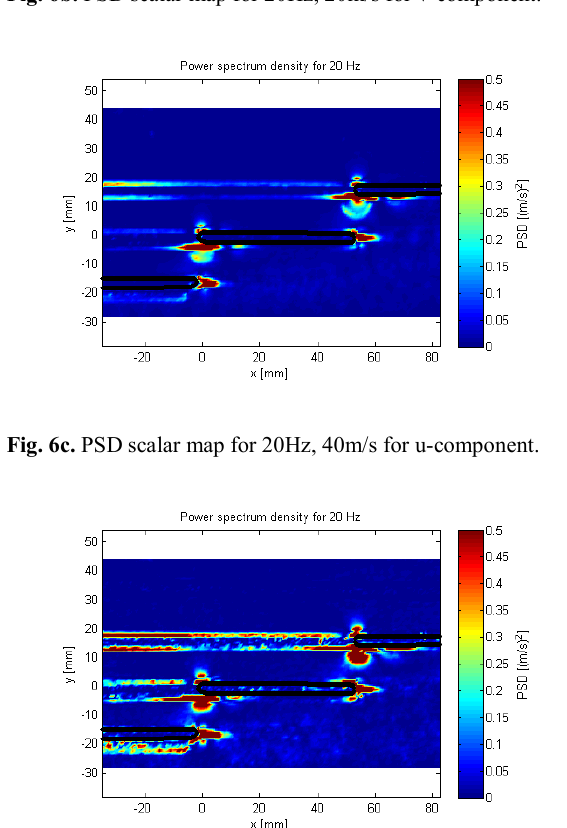
Fig. 7b. PSD scalar map for 20Hz , phase angle ϕ= π /2.